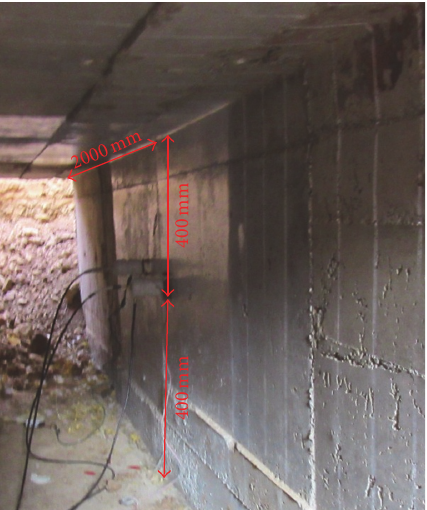
Figure 4: Accelerometer sensors installed on the wall of the